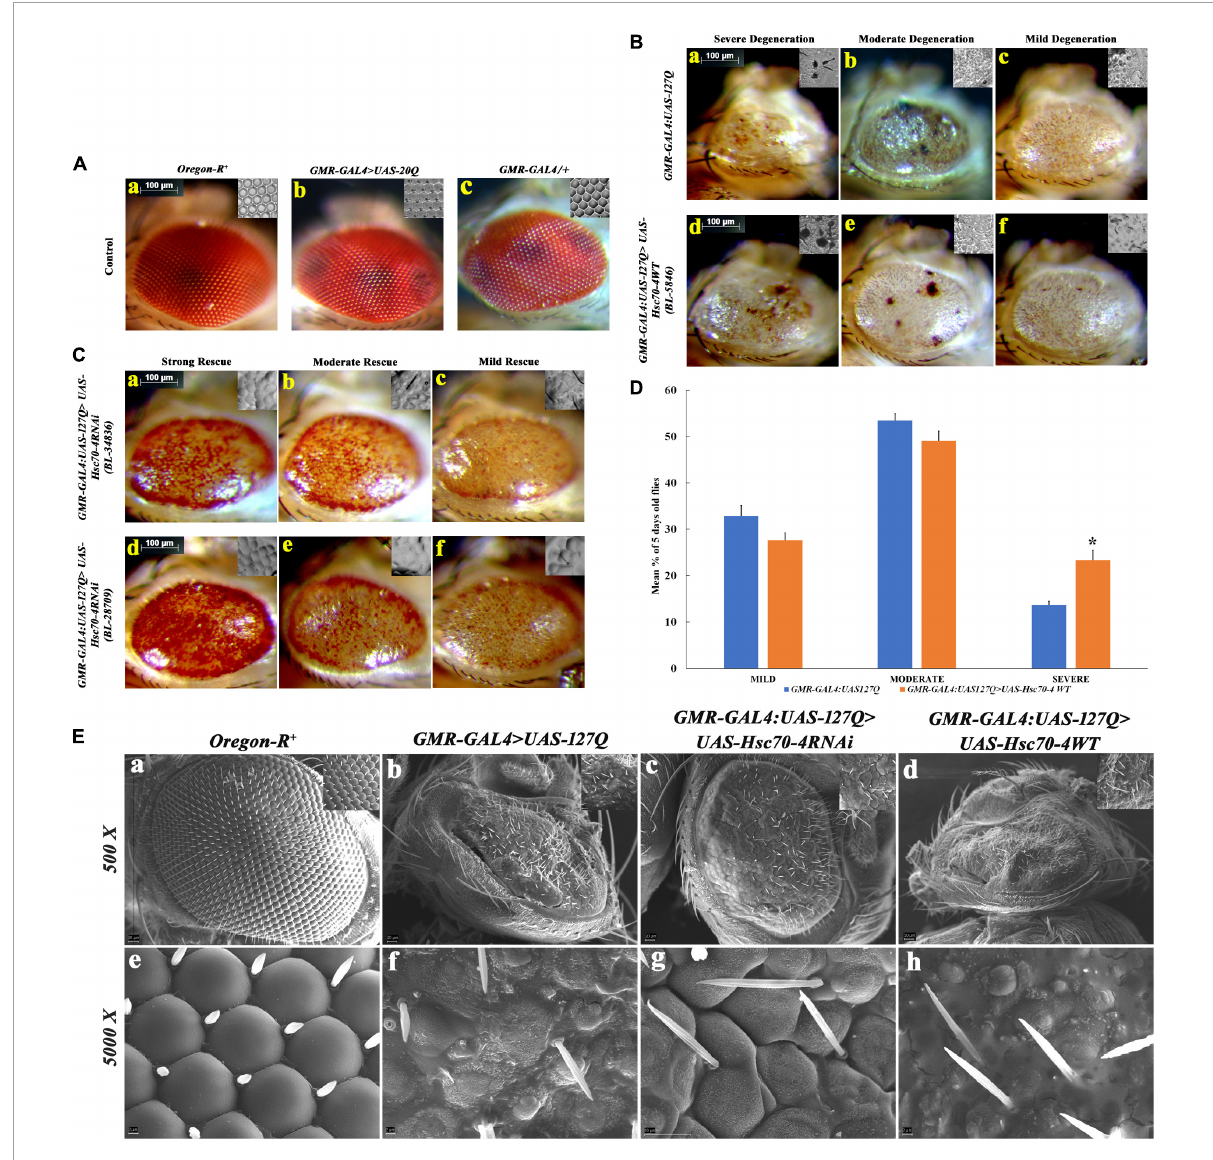
FIGURE2 Detailed morphological observations of eye phenotype in hsc70-4 regulated condition in 5-day-old polyQ- expressing flies. (A) Eye phenotype and ommatidial arrangement of three control genotypes: (a) Oregon-R + ; (b) GMR-GAL4:UAS-20Q ; and (c) , GMR-GAL4/ +. Oregon-R + is the negative control, GMR-GAL4/ + is a positive control, and GMR - GAL4:UAS-20Q is also an experimental control. Both of their eye phenotypes are very similar to that of the negative control group. (B) Degeneration of the eye phenotype is categorized into three groups, and based on this categorization, the frequency of eye degeneration is compared between polyQ -expressing flies and hsc70-4 overexpressing polyQ flies. These are (i) mild degeneration in panels (c,f) shows less roughening in the eye (with lesions only at the periphery); (ii) moderate level of degeneration in panels (b,e) where degeneration and necrotic patches are present in either of the eyes; and (iii) severe degeneration in panels (a,d) where the eye size is smaller than the mild eye phenotype along with larger necrotic patches (scale bar 100 µ m). (C) Rescue in the eye phenotype after the downregulation of hsc70-4 in GMR-GAL4:UAS-127Q is checked using two different RNAi lines. The rescue phenotype is categorized into three groups: (i) mild rescue phenotype in panels (c,f) shows recovery in the eye pigmentation at the margin and slight improvement in the ommatidial arrangements. (ii) Moderate rescue in panels (b,e) leads to the recovery of the loss of pigmentation throughout the eye and the recovered ommatidia. (iii) High rescue phenotype in panels (a,d) where eye pigmentation is very prominent along with a highly recovered ommatidial pattern (scale bar 100 µ m). (D) The graph shows the severity of eye degeneration change upon overexpressing the hsc70-4 in the GMR-GAL4:UAS-127Q background. Slight changes in the percentage of flies with either mild and moderate degenerating eye phenotype have been observed between GMR-GAL4:UAS-127Q and GMR-GAL4:UAS-127Q > UAS-Hsc70-4WT , whereas a significant increase in the percentage of the severe eye phenotype bearing 5-day-old flies which suggests an increase in ocular degeneration after overexpressing hsc70-4 . The eye phenotype of each genotype was observed after three independent crosses and n ≥ 100, and data are shown as ± SEM (* indicated significance at the p -value of ≤ 0.05). (E) SEM image panels show the eye phenotype of different genotypes in detail. (a,e) Oregon-R + , (b,f) GMR-GAL4:UAS-127Q , (c,g) GMR-GAL4:UAS-127Q > UAS-Hsc70-4RNAi, and (d,h) GMR-GAL4:UAS-127Q > UAS-Hsc70-4WT (scale bar 20 µ